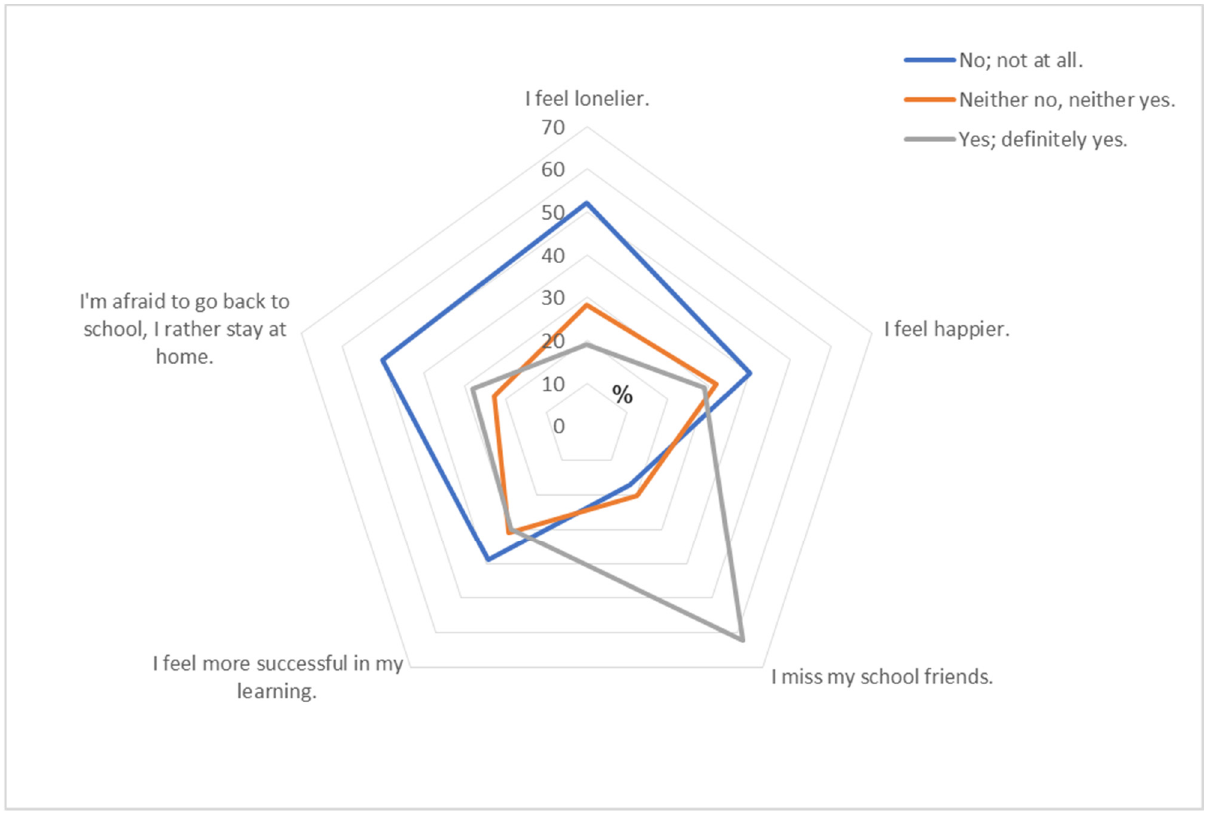
Figure 1. Graphical presentation of school children’ feeling and worries about COVID-19 lockdown and staying at home.